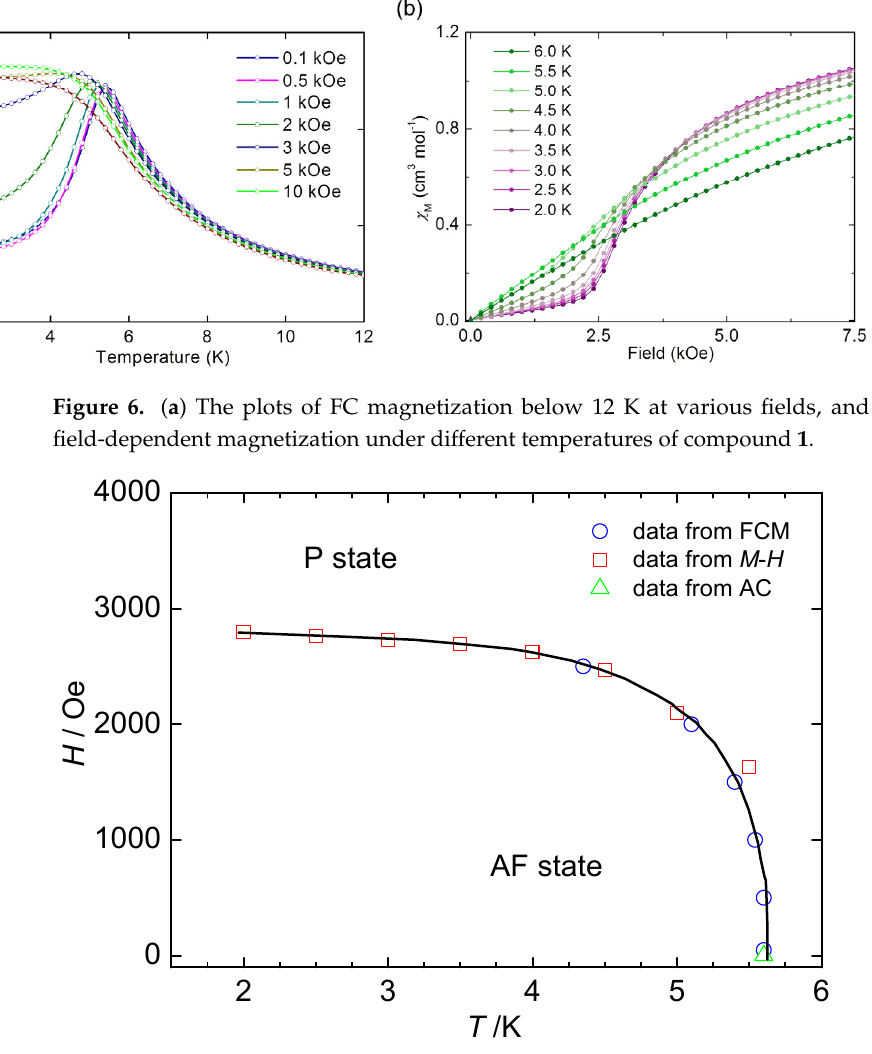
pattern (black) of compound 1 , Figure S2: Thermogravimetric (TG) analysis diagram of compound 1 powdered sample of compound 1 , Figure S3: Plot of χ M − 1 ( ○ ) vs. T of compound 1 . The solid line represents the best fit χ M − 1 above 500 K with a Curie-Weiss law, Figure S4: Plot of χ M ( ○ ) vs. T of compound 1 , Figure S5: Magnetic exchange coupling scheme of [Ni 3 ( μ 3 -CrO 4 )]-based layer of compound 1 , Figure S6: ZFC/FC magnetizations of compound 1 at the field of 10 Oe, Figure S7: In phase ( χ′ ) and out-off phase ( χ′′ ) of the AC magnetic susceptibilities in a zero applied DC field and a 3.5 G AC field at the indicated frequencies for compound 1 , Figure S8: A blow-up of the hystere- sis loop of compound 1 at the 1.8 K, Figure S9: d M /d H vs. H plots for the virgin magnetization of compound 1 . Author Contributions: C.-I.Y. conceived and designed the experiments; H.-Y.T. performed the experiments; G.-H.L. contributed to the single-crystal X-ray data collection and structural analysis; K.-K.N. contributed to magnetic analysis; C.-I.Y. wrote the paper. All authors have read and agreed to the published version of the manuscript. Funding: This research was funded by Tungahi University and Ministry of Science and Technolo- gy, Taiwan (MOST 110-2113-M-029-012, MOST 110-2112-M-029-004, MOST 110-2112-M-029-006, and MOST 111-2731-M-007-001).